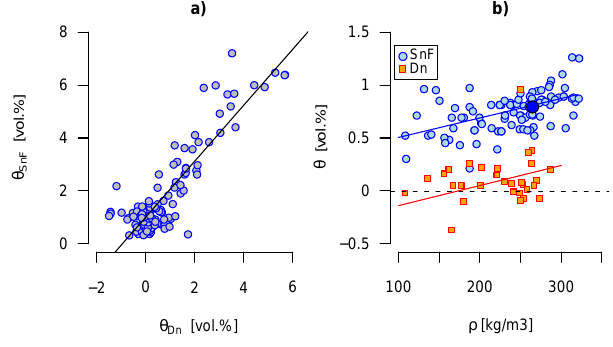
Table 3. Data overview: shown are the number of days ( n day ), locations ( n loc ), measurement depths ( n depth ) and single measure- ments (n) for the various measurement modes (Fig. 4) using the Snow Fork (SnF), and for the comparison between SnF and Denoth instrument (Dn).